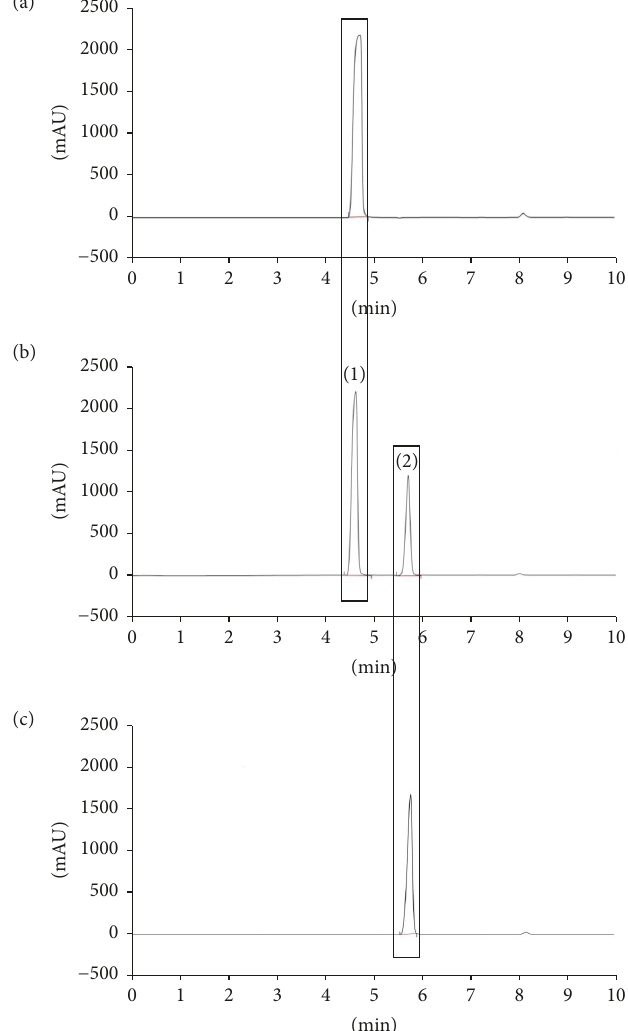
Figure5:ComparativechromatogramsshowingisocraticRP-HPLCseparationofindividualandmixedstandard,L-citrulline,andL-arginine using Gemini C 18 : (a) L-arginine, (b) mixed standard, and (c) L-citrulline. The peaks marked represent (1) L-arginine and (2)